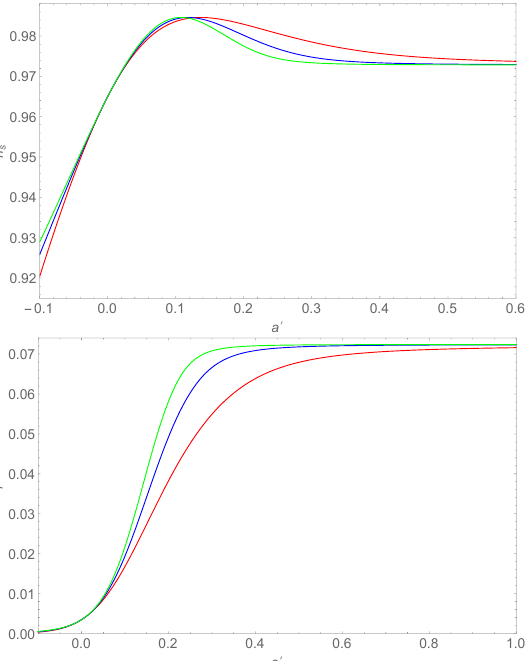
Figure 2 . n S vs a 0 (left) and r vs a 0 (right) for ξ = 100 (red curve), 1000 (blue curve), 5000 (green curve).